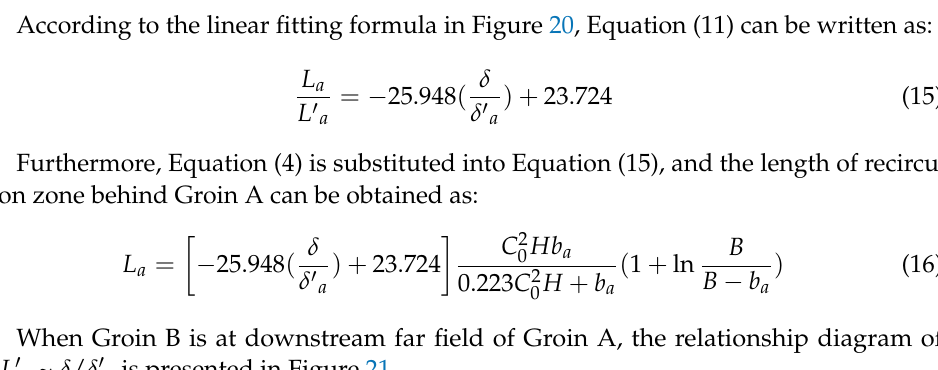
Figure 20. The relationship between L a / L’ a and δ / δ’ a when groin B is in the near-field of groin A.